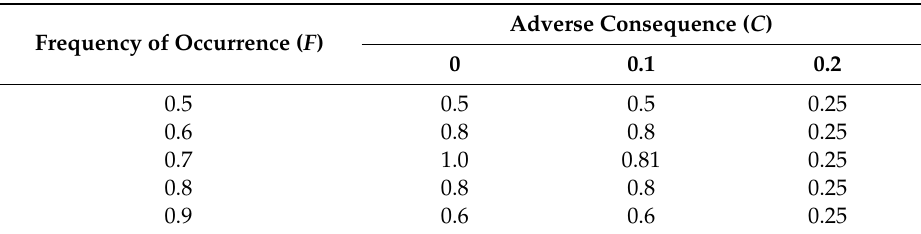
Table 4. Fuzzy relation R ( F , C ).